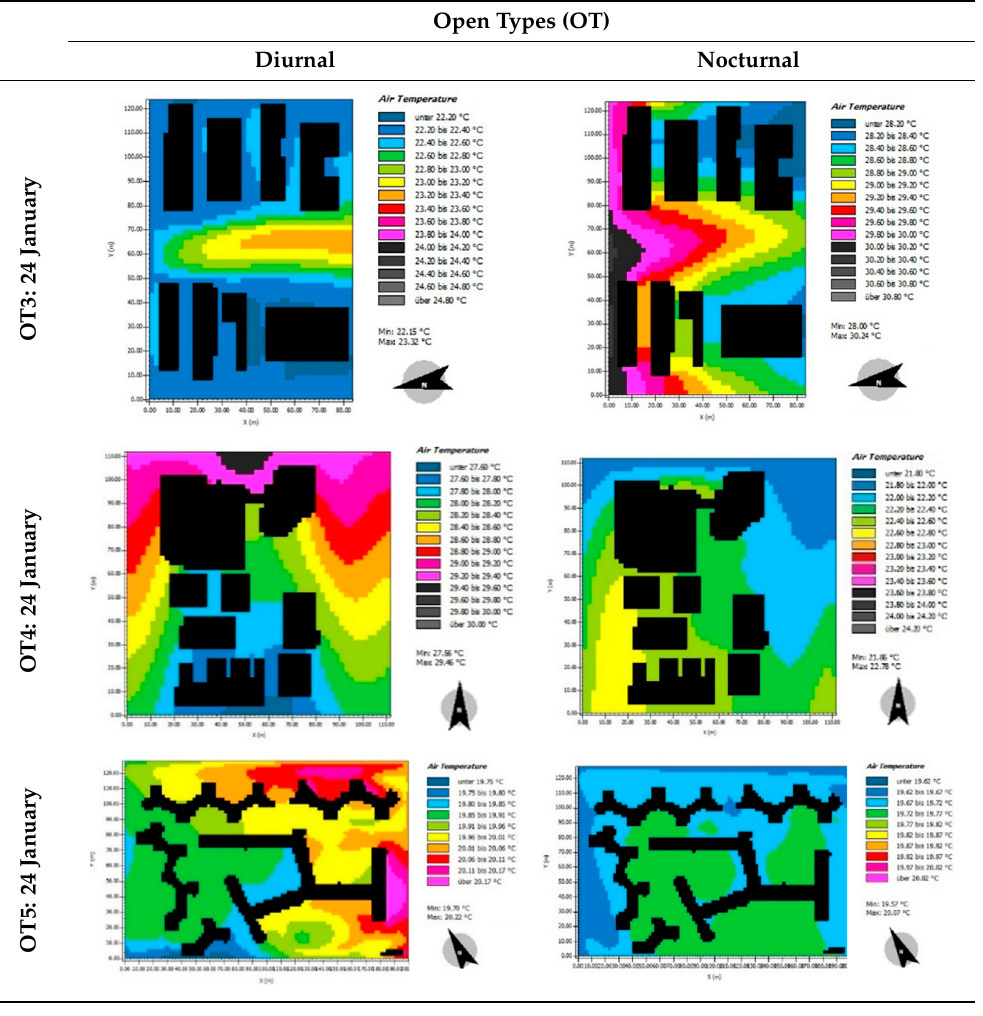
Table 12. Comparison summary of diurnal and nocturnal ambient air temperature distribution map in OT3, OT4, and OT5 on 24th January.